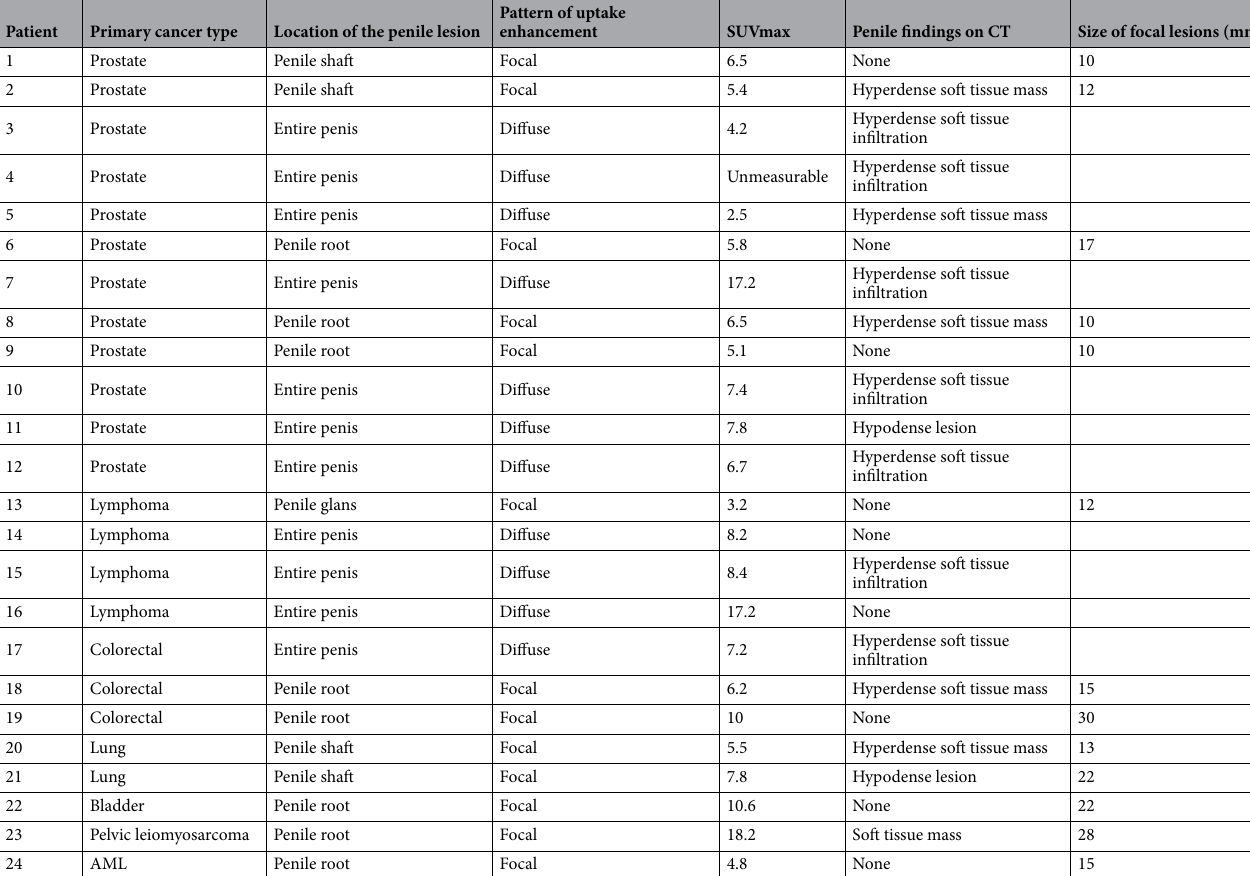
Table 1. Characteristics of penile lesions seen on PET/CT according to primary malignancy.